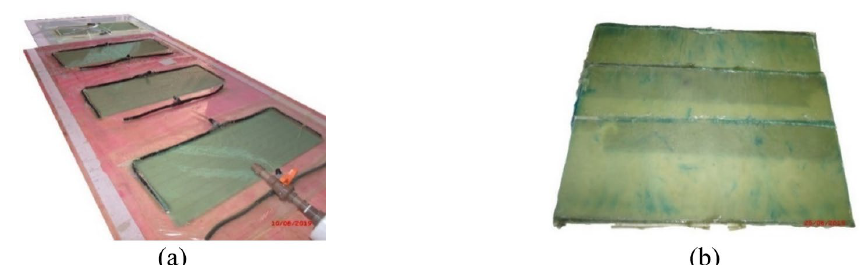
Figure 3. GFRP composite plates production process: (a) aspect of the plates immediately after partial curing, still inside the infusion bag; (b) aspect of the composite plates after the removal of vacuum, and the air flow and peel ply